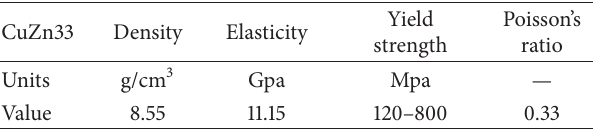
Table 2: The plastic data of samples. Table 3: The performance parameters of Graphit-ic